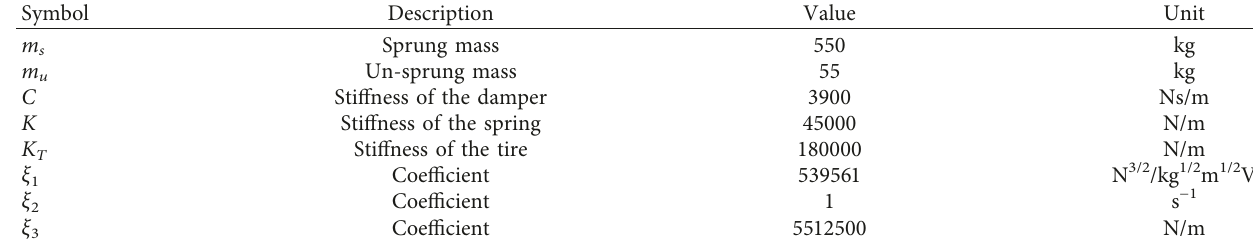
Figure 3: Control system Table 1: Parameters of the dynamics model.